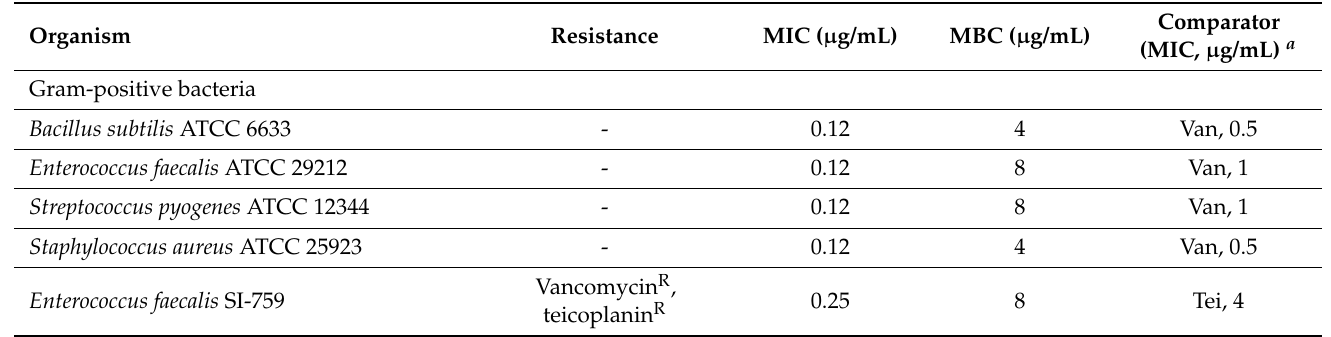
Table 4. In vitro antibacterial activity (MIC and MBC values) of lunaemycin A on reference strains and clinical isolates with various phenotypes of resistance to antibiotics.